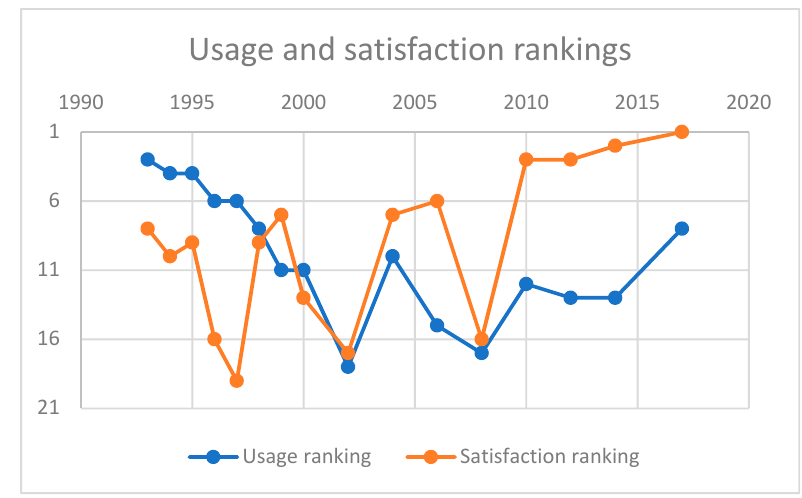
Figure 5. Usage and satisfaction rankings (Source: Bain & Company’s surveys 1993–2017).